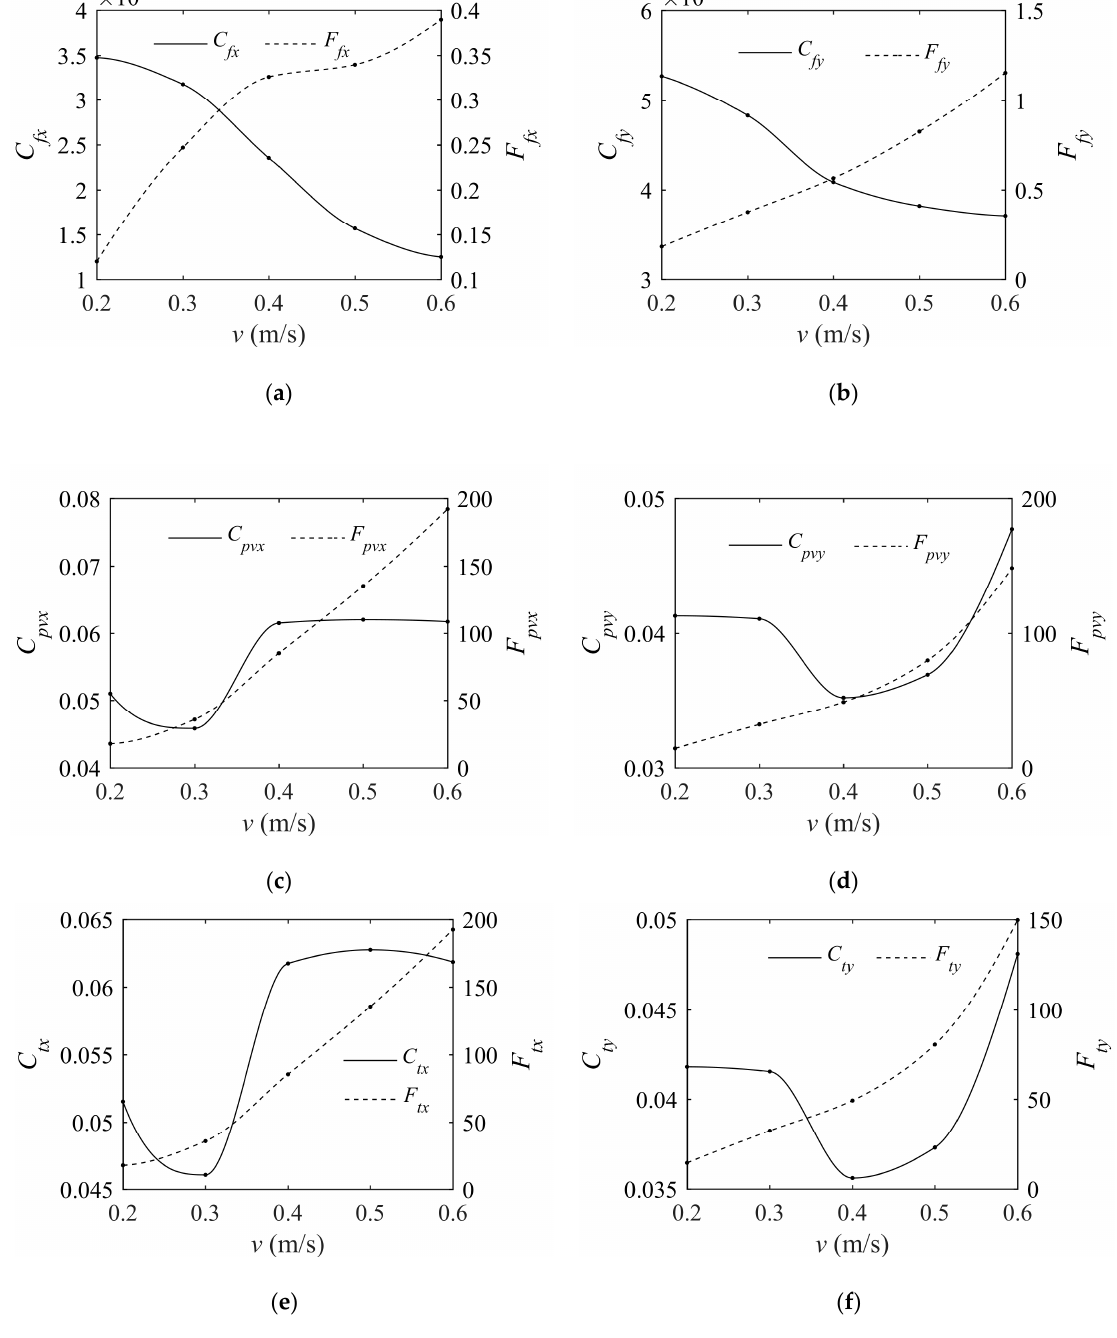
Figure 20. The variation of the resistance coefficients: ( a ) frictional resistance coefficient in the X-direction, ( b ) frictional resistance coefficient in the Y-direction, ( c ) pressure resistance coefficient in the X-direction, ( d ) pressure resistance coefficient in the Y-direction, ( e ) total resistance coefficient in the X-direction, ( f ) total resistance coefficient in the Y-direction.